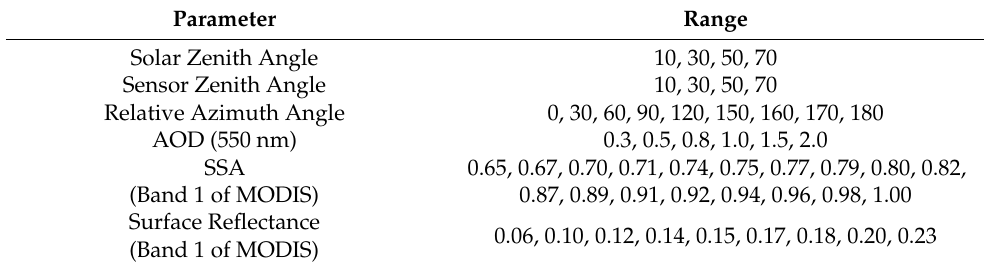
Table 2. List of input parameters of 6S model.